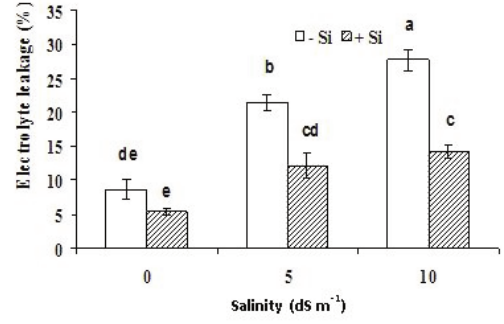
Fig. 4 - Interaction effects of different salinity and Si levels on electrolyte leakage of P. pratensis after 90 days. Data are mean ± SE at P ≤0.05 using LSD test.